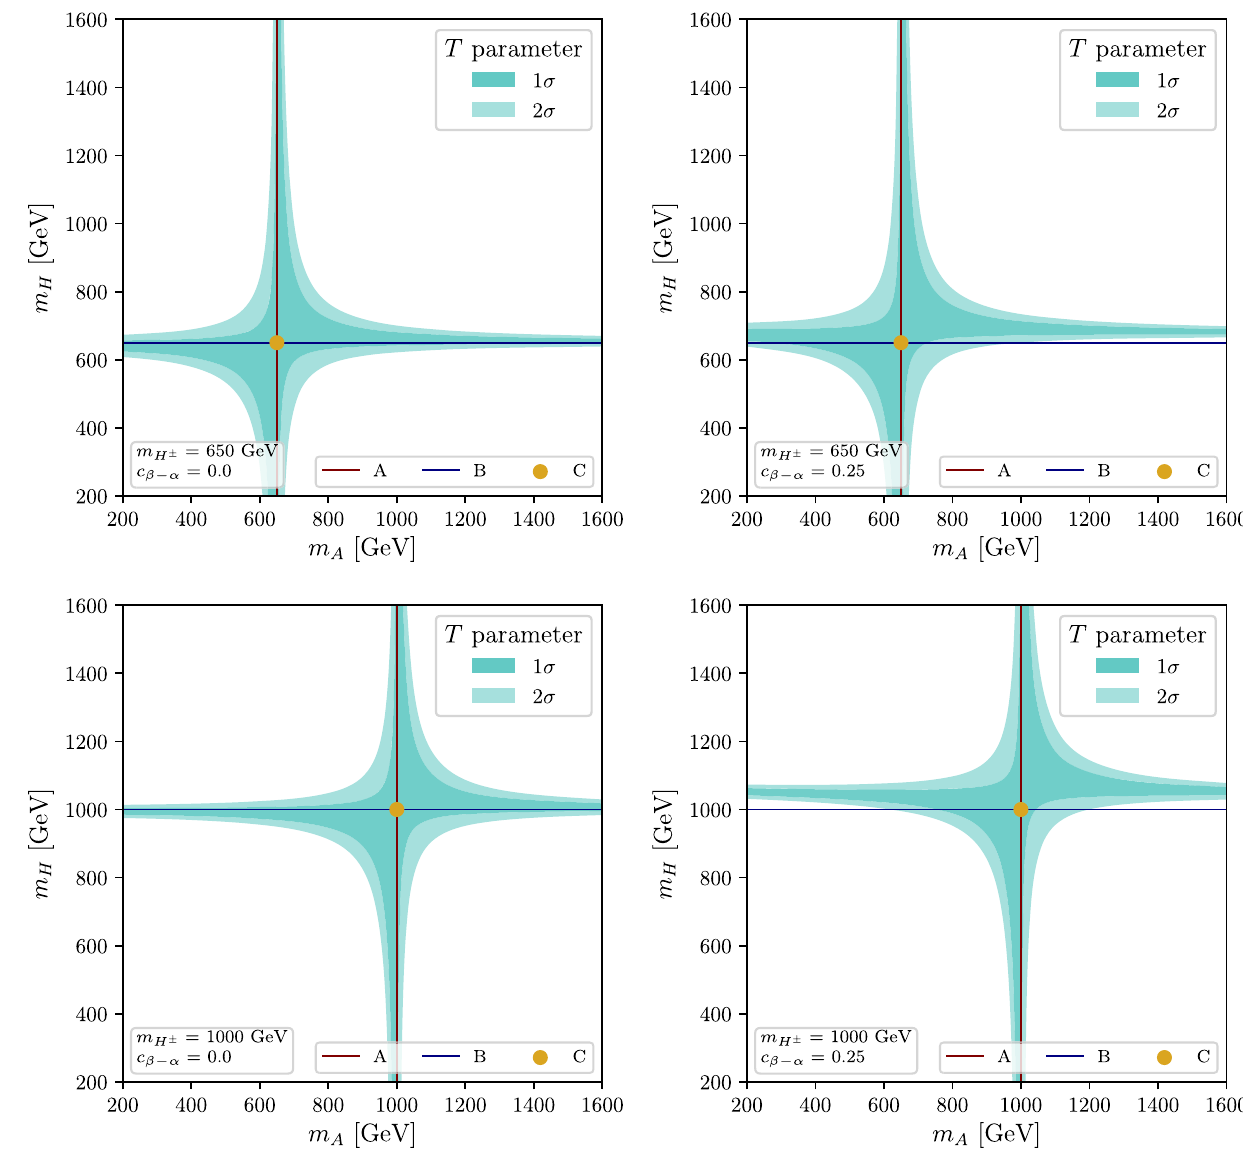
Fig. 4 T parameter for m H ± = 650 GeV (top) and m H ± = 1000 GeV (bottom) in the alignment limit, c β − α = 0, (left) and for c β − α = 0 . 25 (right). In scenario A m H ± = m A (red lines), in scenario B m H ± = m H (blue lines), and in scenario C m H ± = m H = m A (yellow